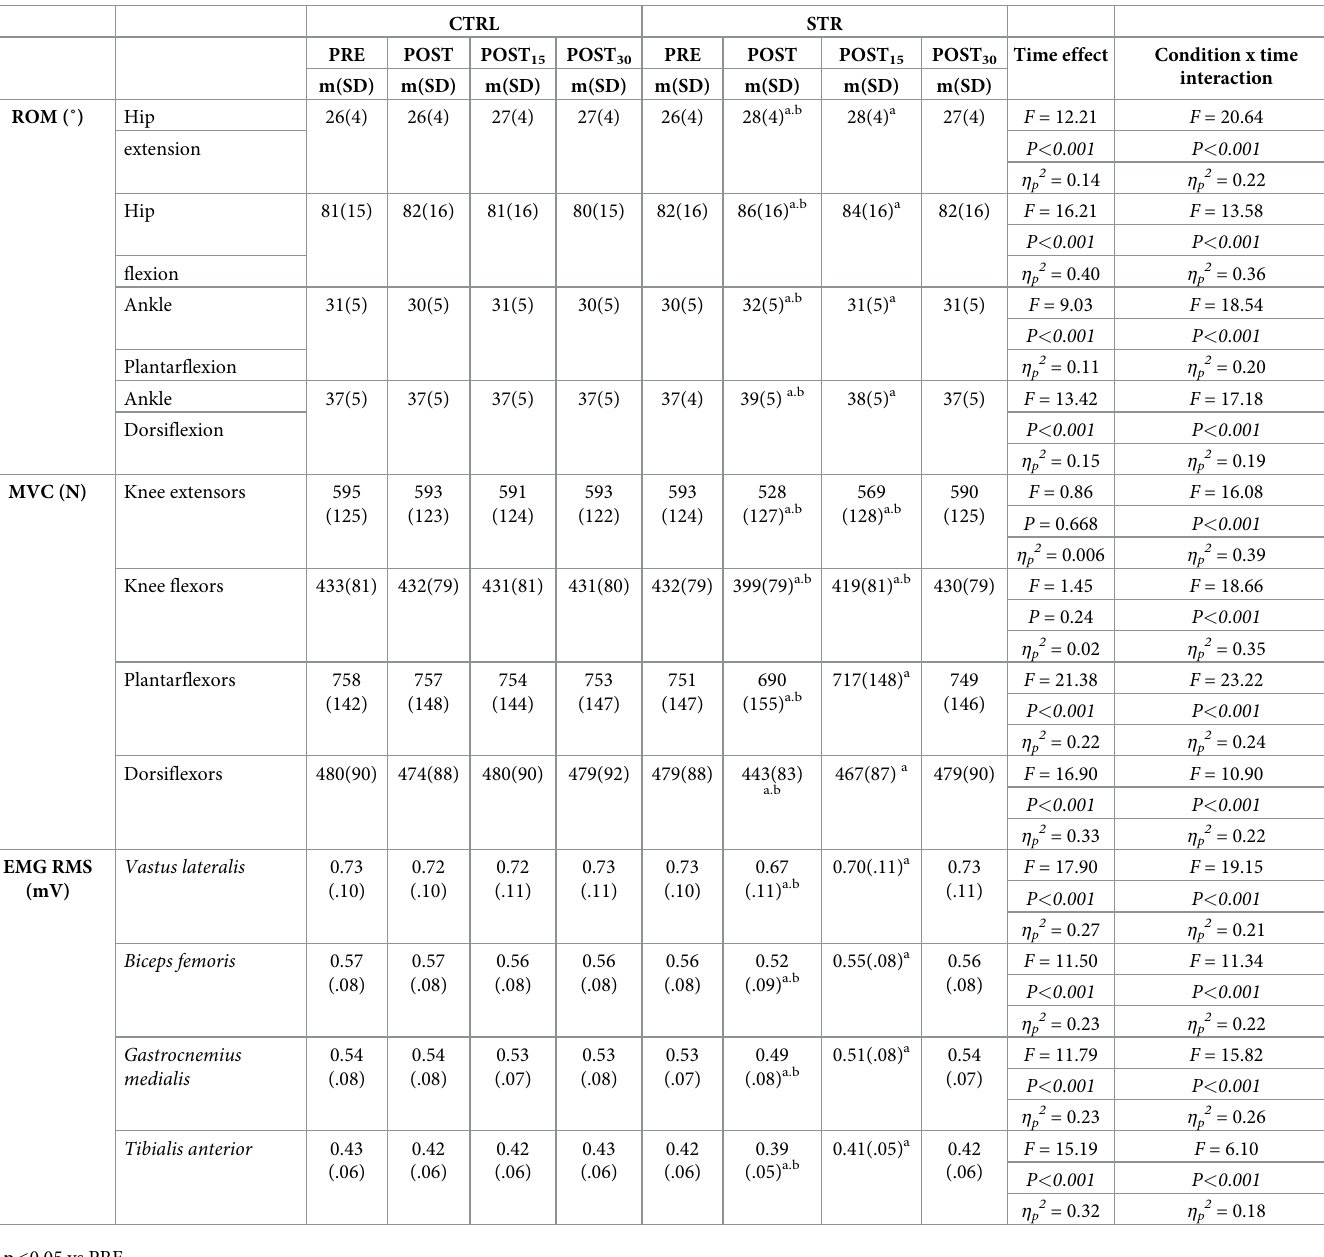
Table 2. Time course of range of motion (ROM), maximum voluntary contraction (MVC), and root mean square of the surface electromyographic signal (sEMG RMS) in the control (CTRL) and stretching session